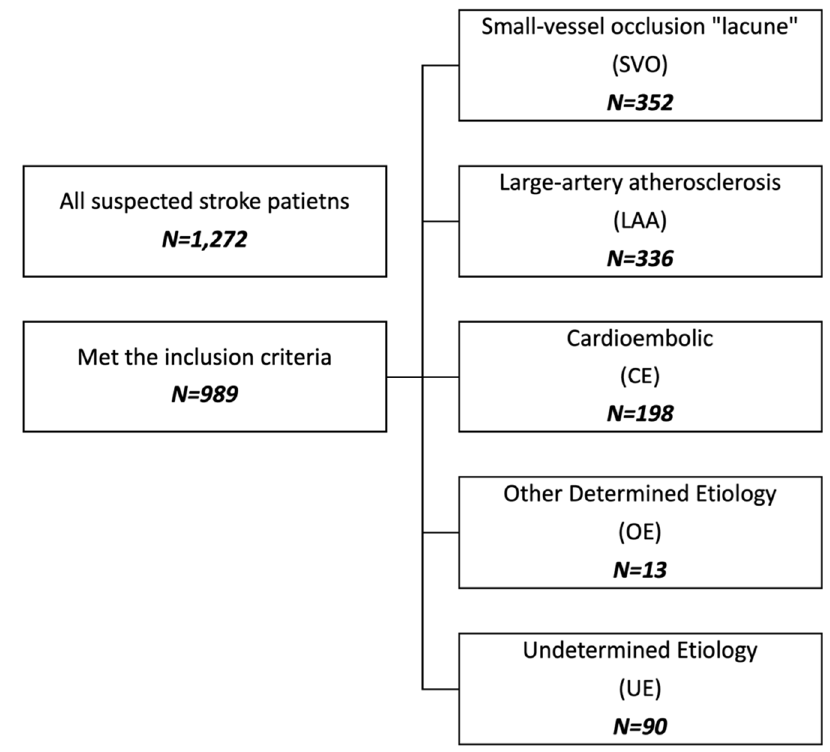
Figure 1. Study participants.